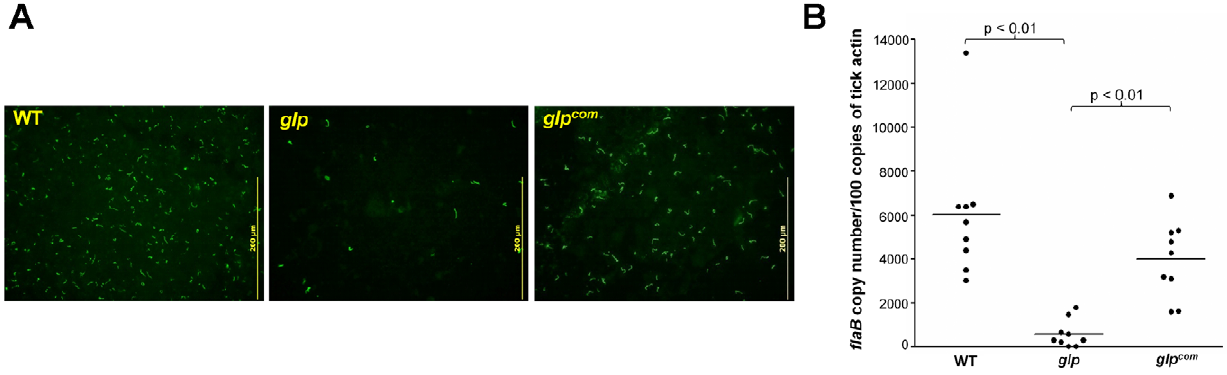
Figure 7. Glycerol transport/metabolism is important during tick residence. Naı¨ve larvae fed on needle inoculated C3H/HeN mice infected with wild-type, glp , or glp com . Fed larvae were allowed to molt to nymphs. Infected unfed nymphs were then fed on naı¨ve mice to produce fed nymphs. Fed nymphs were then subjected to IFA analysis ( A ) and qPCR analysis ( B ). For qPCR, copies of the B. burgdorferi flaB genes were chosen to represent spirochete numbers and the values were reported relative to 100 copies of the tick actin gene. Each data point is from one